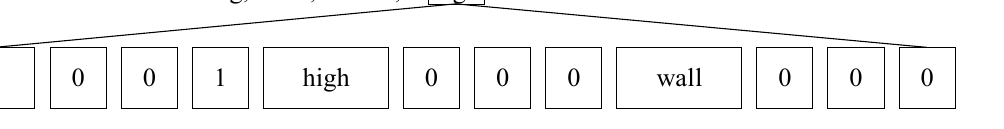
Figure 6. Feature vector for the CRF